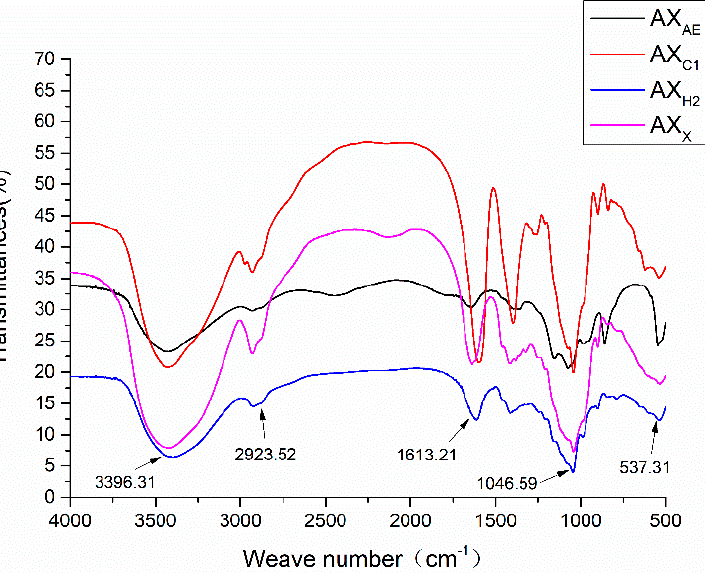
Figure 2. FT-IR spectra of AXH. AX AE , triticale bran arabinoxylan was treated with α -L- arabinofuranosidase; AX C1 , triticale bran arabinoxylan was treated with 0.1 M citric acid; AX H2 , triticale bran arabinoxylan was treated with 0.15 M HCL; AX X , triticale bran arabinoxylan was treated with endo − 1,4 − β − xylanase.